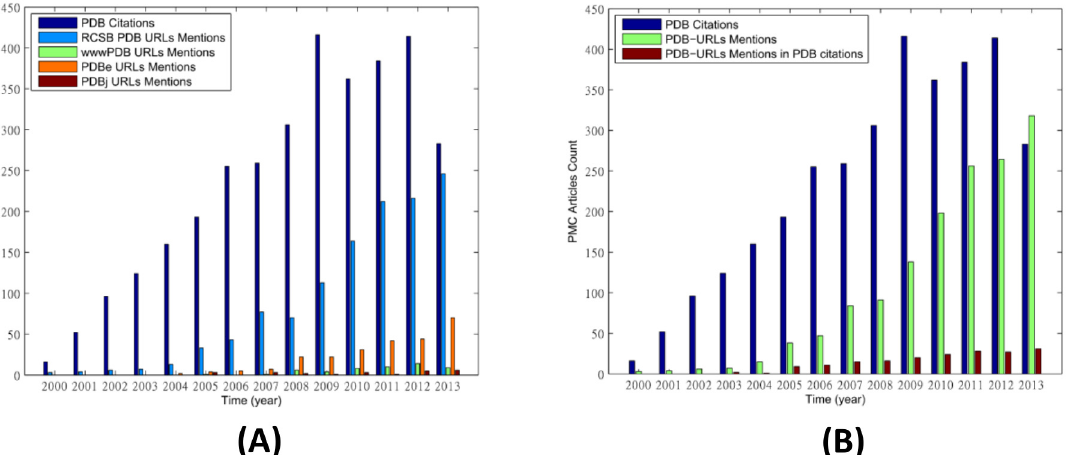
Fig 5. (A) Annual growth of the citations to the PDB debut paper and the counts of the different PDB URL mentions. (B) Annual growth of the citations to the PDB debut paper (blue bar), sum of all PDB URL mentions (green bar) and the count of the articles that not only directly cite the PDB debut paper but also mention PDB URLs (red